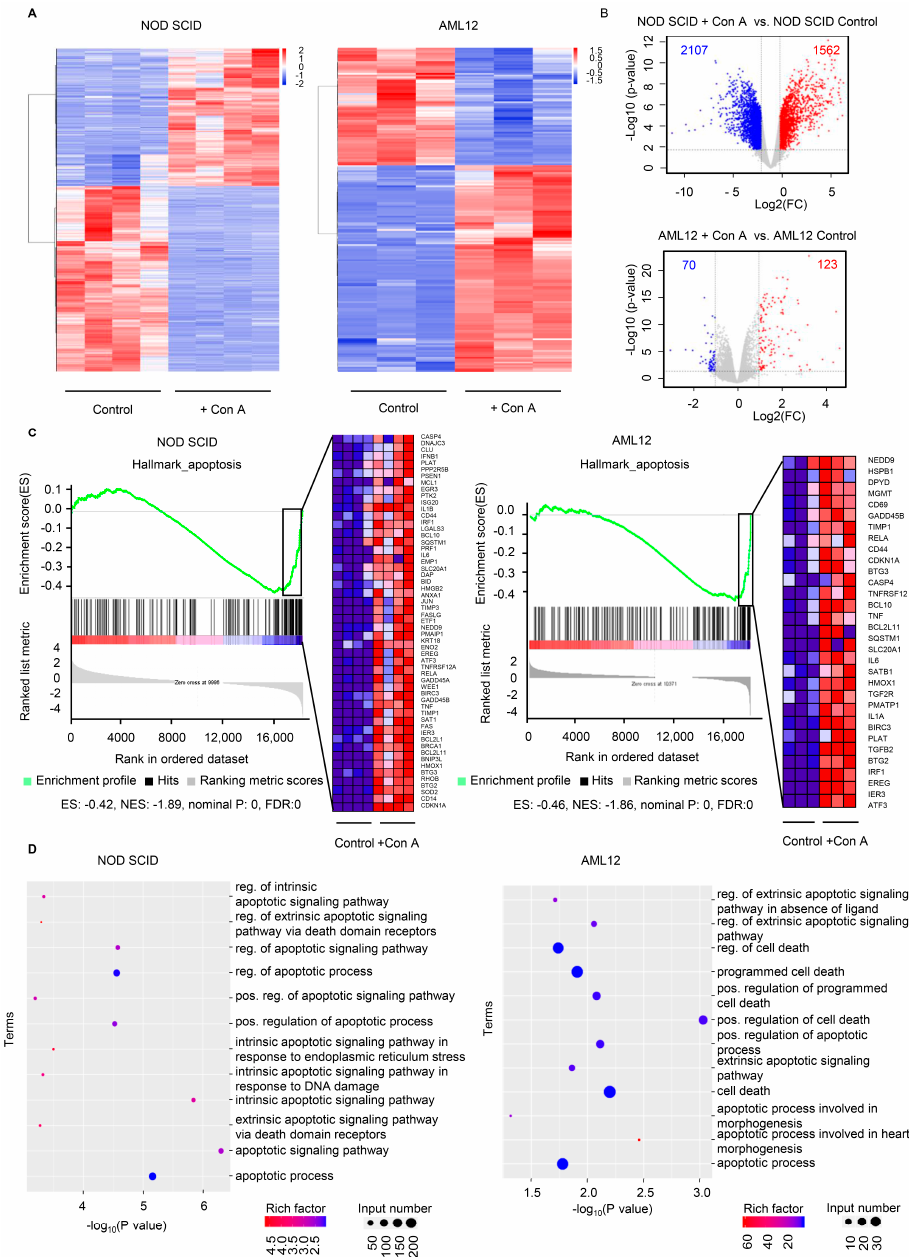
Figure 4. The expression of apoptosis-related genes was elevated in response to Con A treatment both in vivo and in vitro. RNA was obtained from the livers of NOD SCID mice 8 h after Con A (25 mg/kg) or vehicle administration, or from AML12 cells treated for 1 h with Con A (20 mg/mL) or vehicle, then analyzed by RNA-Seq or characterization. ( A ) Heatmap of differentially expressed genes (DEGs). The color code indicates intensity of gene expression from high (red) to low (blue). ( B ) Volcano plot visualizing the DEGs between the control and Con A-treated groups. |Log2FC| ≥ 1 and q < 0.05 were used as the threshold to determine the significance of DEGs. FC, -fold change. Red dots represent genes with increased expression, blue dots represent genes with decreased expression, and gray dots indicate transcripts that did not change significantly. ( C ) Transcripts from the upregulated genes from both the in vivo and in vitro models that were determined to be enriched in apoptosis-related terms according to gene set enrichment analysis (GSEA) analysis. ES, enrichment score; NES, normalized enrichment score; FDR, false-discovery rate. ( D ) Gene ontology (GO) analysis showed the enriched pathways of upregulated genes from the in vivo and in vitro